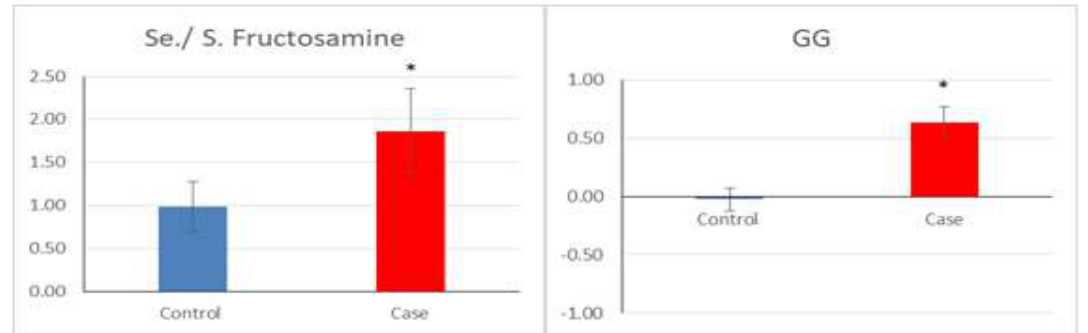
Figure 2. Seminal plasma/ serum fructosamine (left) and Glycosylation gap (Right). Blue represent control group and Red represent infertile male